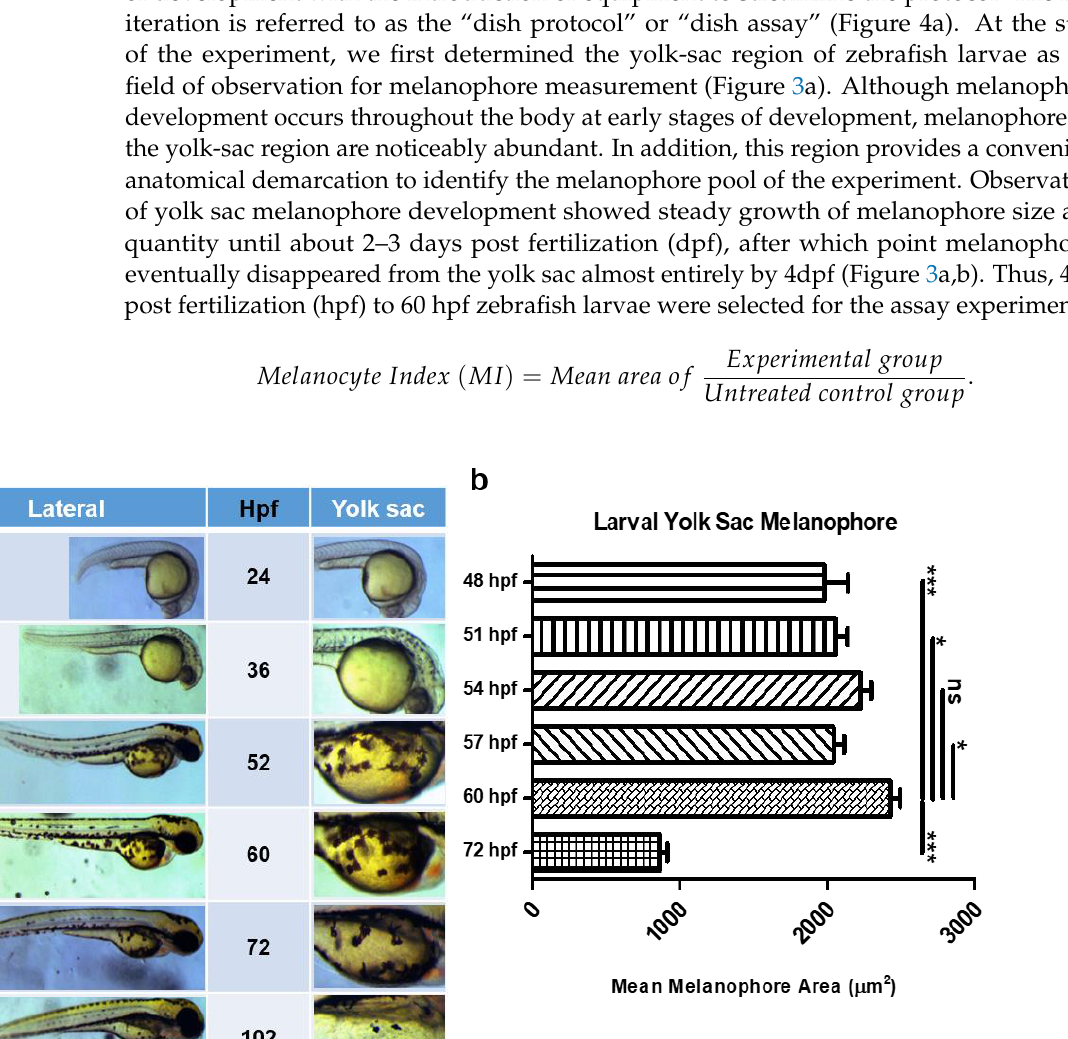
Figure 2. Sequence analysis and alignment of naturally- occurring α -MSH variants. ( a ) Clustal Omega alignment of four α -MSH variants in different species with human sequence as reference (dotted red box). Percentage Identity color scheme. The region demarcated by green bars indicates the 13-amino- acid α -MSH peptide. ( b ) Table listing the accession number of each α - MSH form used in the melanophore assay, including aliases for each species. The α -MSH sequences indicate the sequence of generated peptides; red letters indicate amino acid variatio ns within the α -MSH peptide, while blue represents the HFRW motif.